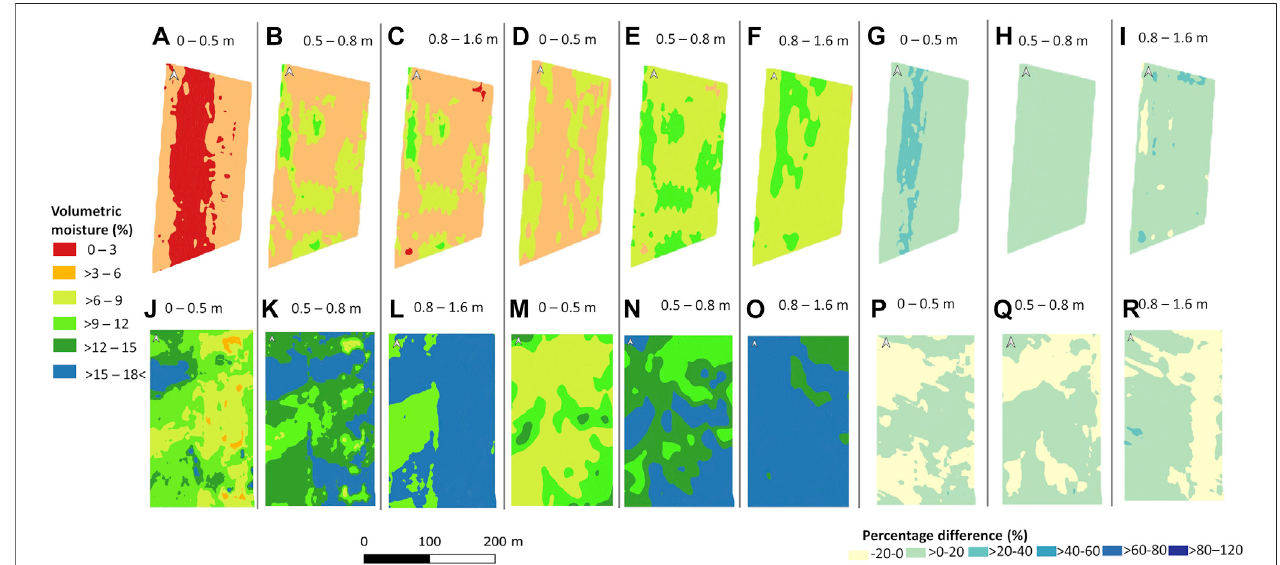
FIGURE 4 | Predicted volumetric moisture content based on inverted EC of three depths (0 – 0.5, 0.5 – 0.8, and 0.8 – 1.6 m) at the Mooribin site [(dry season — A – C and wet season — D – F )] and percentage difference between the volumetric moisture content of both seasons (G – I) . Similarly, predicted volumetric moisture content at the Kukerin site (dry season — J – L and wet season — M – O ) and percentage difference relative to dry season between the volumetric moisture content of both seasons (P – R) .